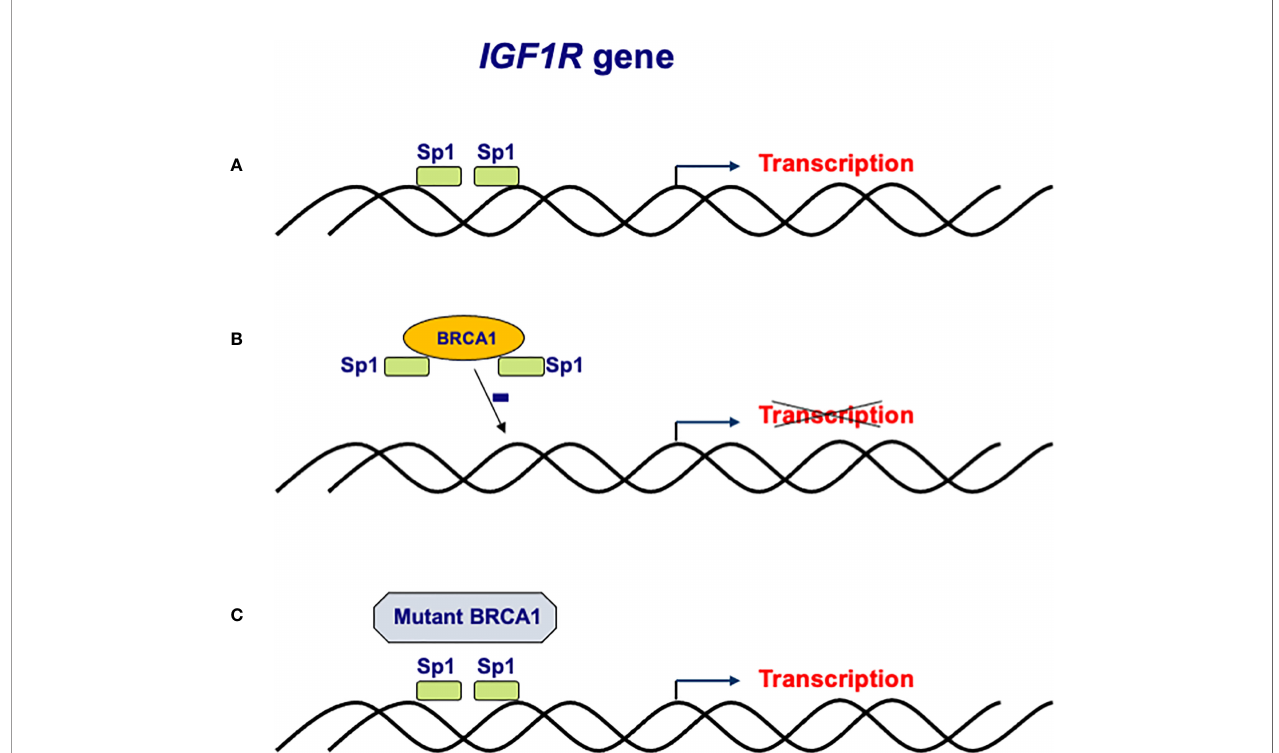
FIGURE 2 | Regulation of IGF1R gene expression by BRCA1. (A) The IGF1R gene promoter includes a number of high af fi nity binding sites for transcription factor Sp1 in its proximal region. (B) The mechanism of action of BRCA1 involves binding to, and sequestration of, Sp1, thus preventing its binding to cis- elements in the promoter region. Lack of Sp1 binding leads to a reduction in IGF1R promoter activity and IGF1R levels. (C) Loss-of-function mutation of BRCA1 in familial and, potentially, sporadic breast cancer may lead to inactivation of BRCA1. Mutant BRCA1 is unable to bind Sp1 and suppress IGF1R gene transcription. Enhanced IGF1R levels are usually associated with augmented cell